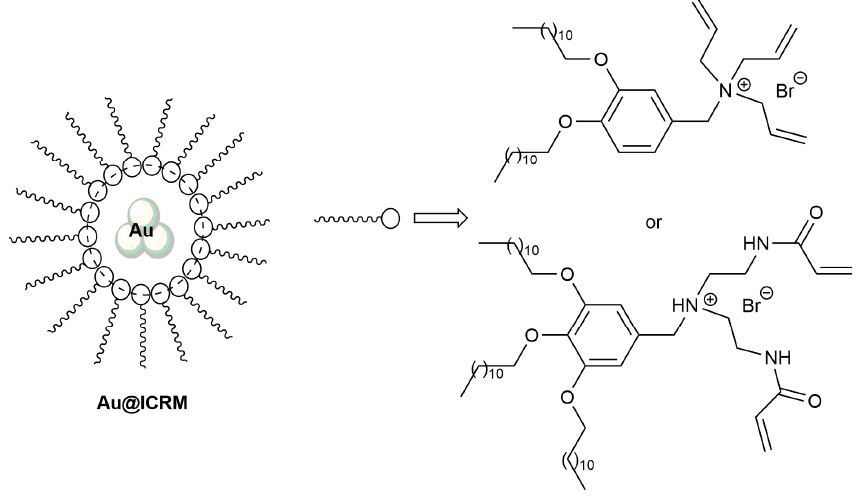
Figure 5. Schematic representation of the Au@ICMR catalysts.